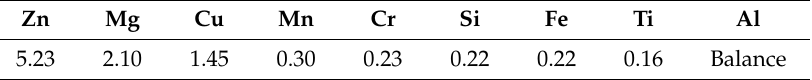
Table 1. Chemical composition of 7075 aluminum alloy (mass fraction,